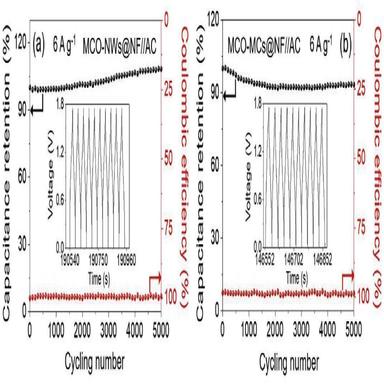
e The capacitance retention (black) and Coulombic efficiency (red) of (a) MCO-NWs@NF//AC HSC and (b) MCO-MCs@NF//AC HSC during 5000 cycles at 6 A g¡1 , and the insets presented the last ten cycles. (For interpretation of the references to color in this figure legend, the reader is referred to the Web version of this article.)